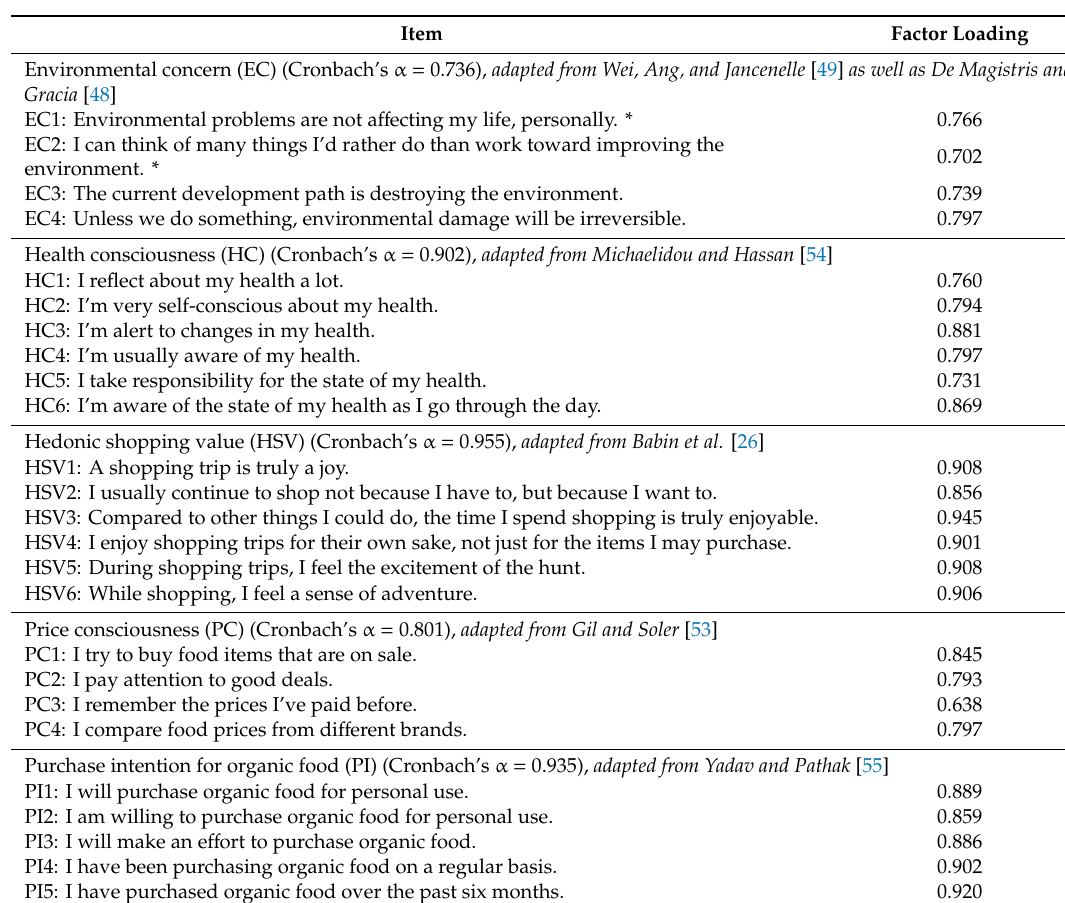
Table 2. Measurement of